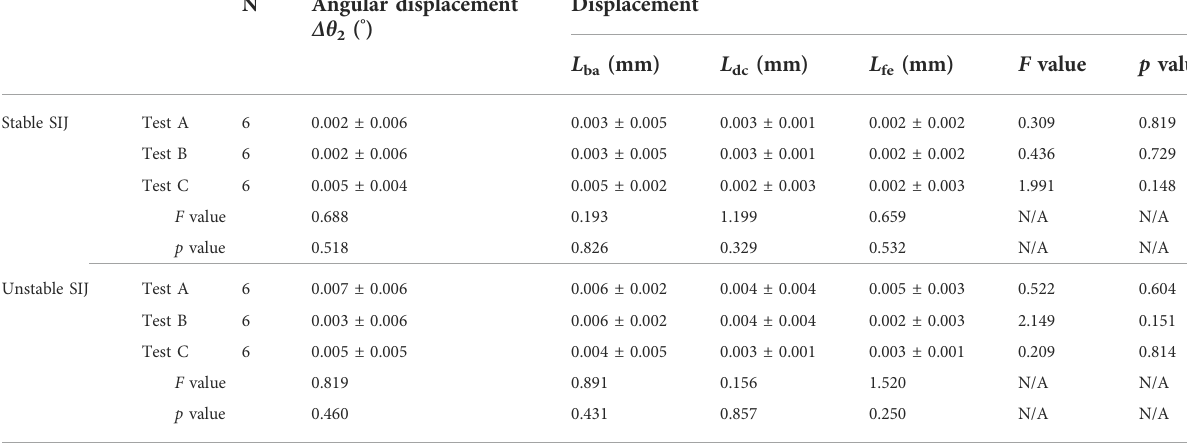
TABLE 2 SIJ nutation and separation recovery during the unloading